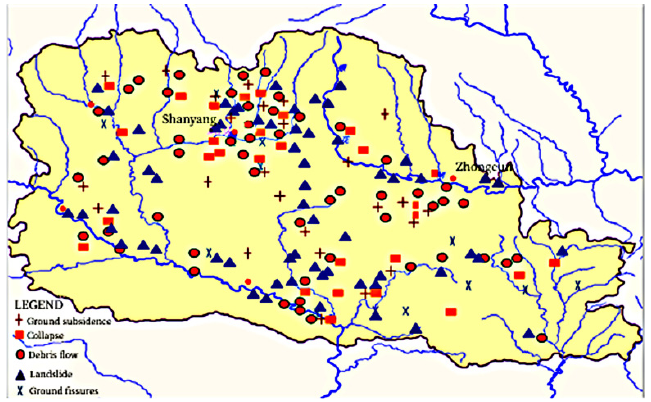
Figure 1. Spatial distribution of geological hazards in the study area.